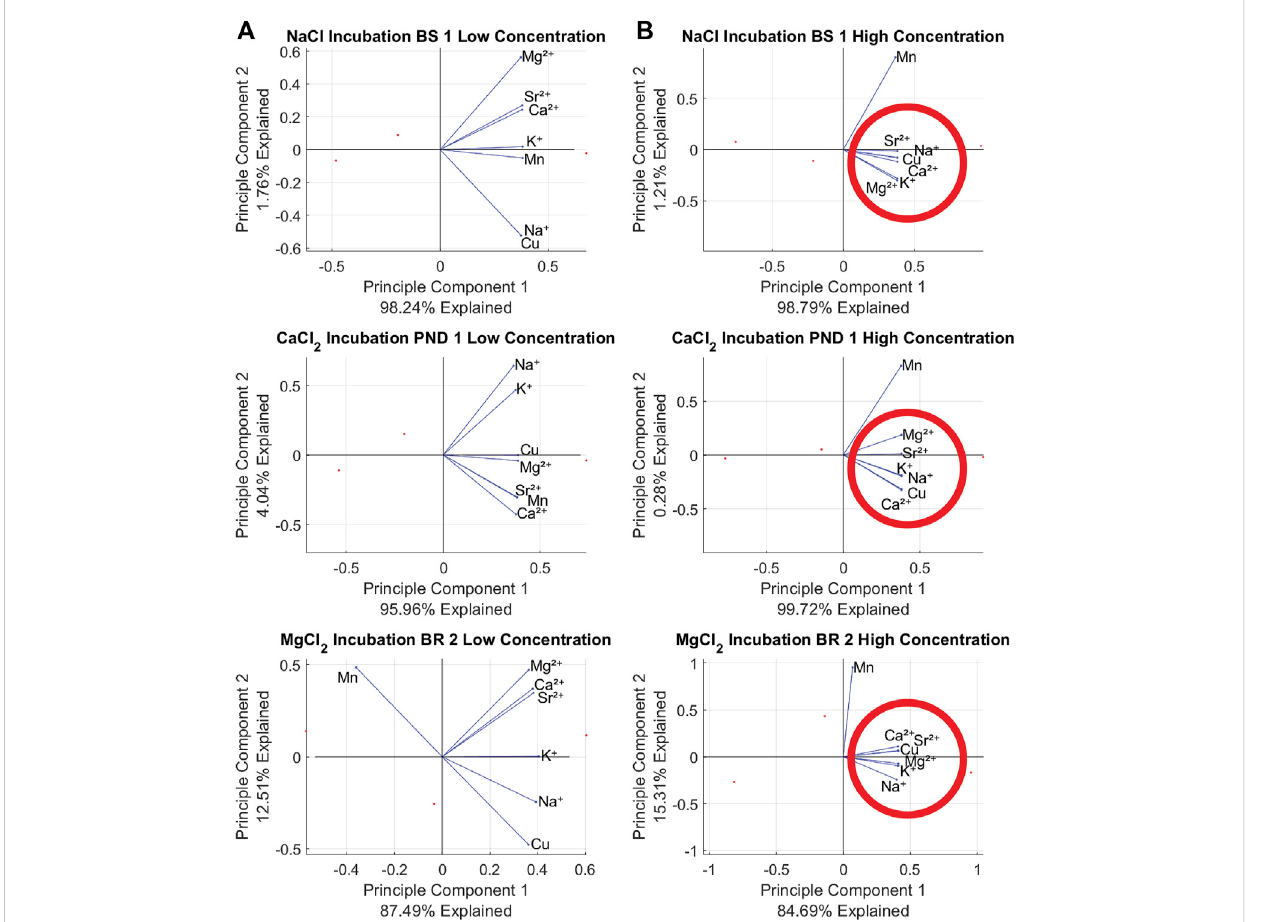
FIGURE 5 PCAplotsshowingchemicalcocktailmobilizationatlow(Milli-Qto1 g/L)andhigh(2.5 – 10 g/L)concentrationsforNaCl,CaCl 2 andMgCl 2 .Bioswale 1,Bioretention2,andPond1areusedasexamplestoshowthisphenomenonisnotisolatedtoonestormwaterBMP.Theformationofchemicalcocktails is highlighted by red circles in the high concentration PCAs. Plots in column (A) are of low concentration and plots in column (B) are of high